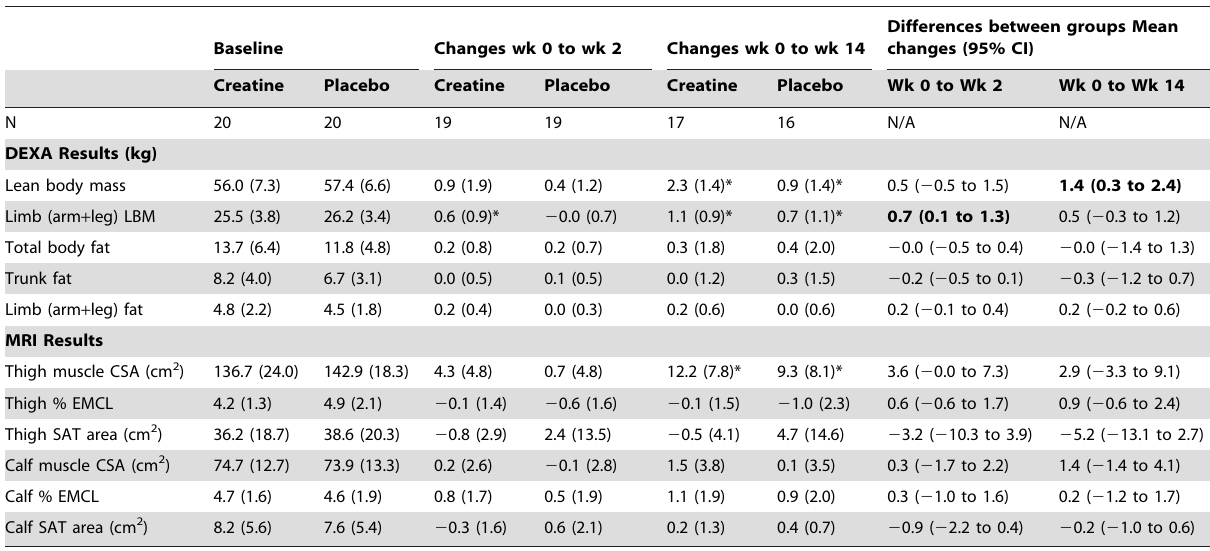
Table 3. Body Composition at Baseline and Changes on Study.